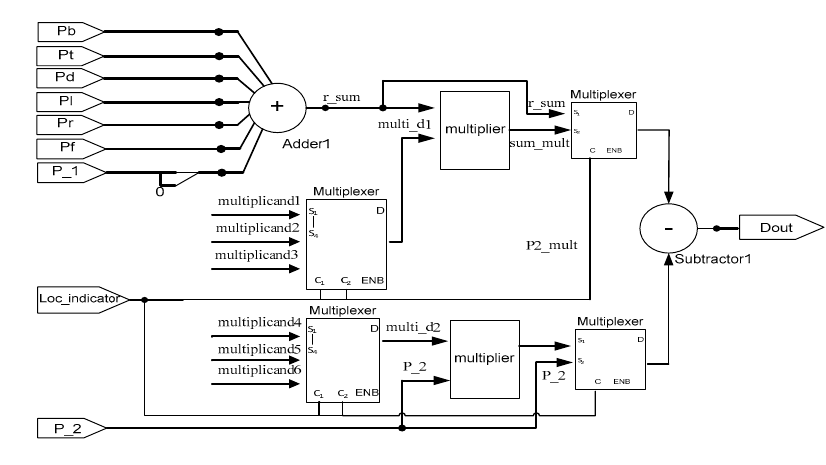
Figure 2. System diagram of the PE.